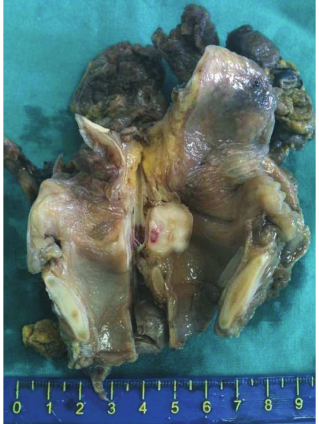
Figure 2: Macroscopic section of the total laryngectomy specimen showing the solid tumoral lesion in the left vocal